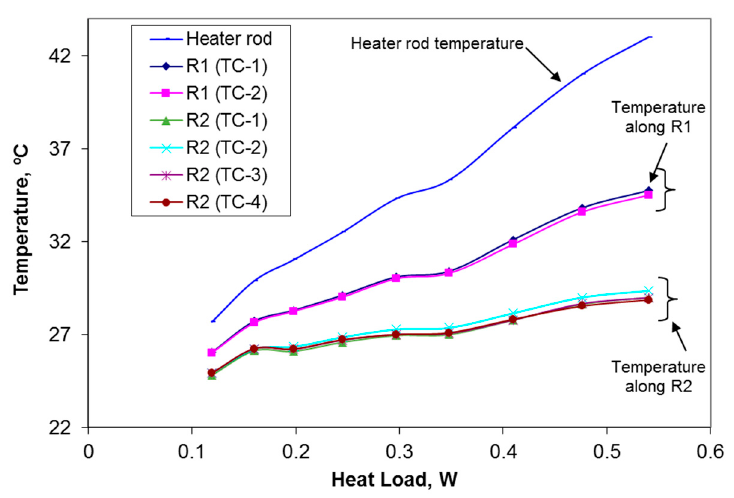
Figure 8. Temperature distributions along the inner ( R 1 ± 0.01) and outer ( R 2 ± 0.01) radiuses of the cylinder measured by cylindrical configuration Figure 8 . Temperature distributions along the inner ( 𝑅 (cid:2869) (cid:3399) 0.01) and outer ( 𝑅 (cid:2870) (cid:3399) 0.01) radiuses of the cylinder measured by cylindrical configuration method